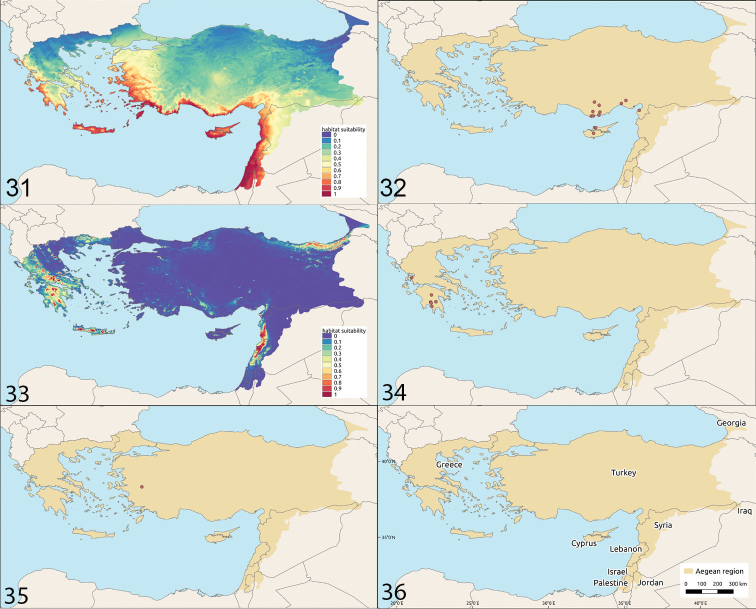
Habitat suitability and distribution 31, 32Camponotus
libanicus33, 34Camponotus
nitidescens35 distribution of Camponotus
schulzi36 the Aegean with adjacent regions.